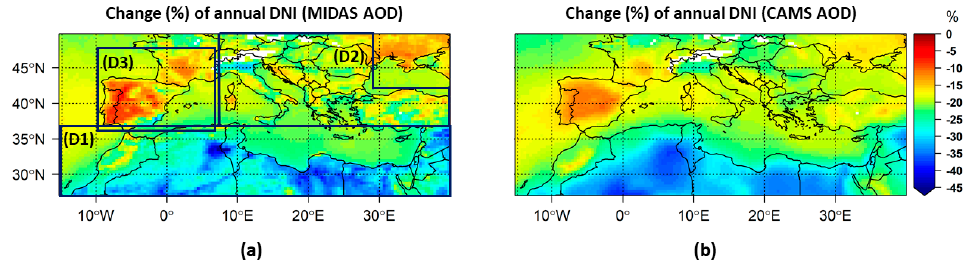
Figure 8. Change (in %) of the mean annual integral of DNI due to the presence of aerosols under ( a ) MIDAS AOD and ( b ) CAMS AOD. Blank grid points are those that did not fulfill the criterion of at least 20% data availability on annual basis.